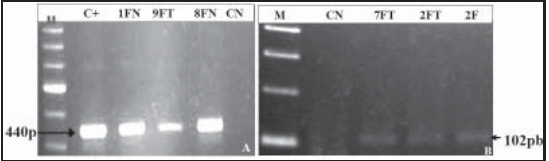
Figura 4 – Géis de agarose 2% mostrando resultados da nested-PCR para um subgrupo de amostras de fígado: A) gene da ciclofi lina. C+ = controle positivo dessa reação, realizado com amostra não-microdissecada. B) éxon 8 do gene TP53. CN = controle negativo; M = marcador 100 pb.